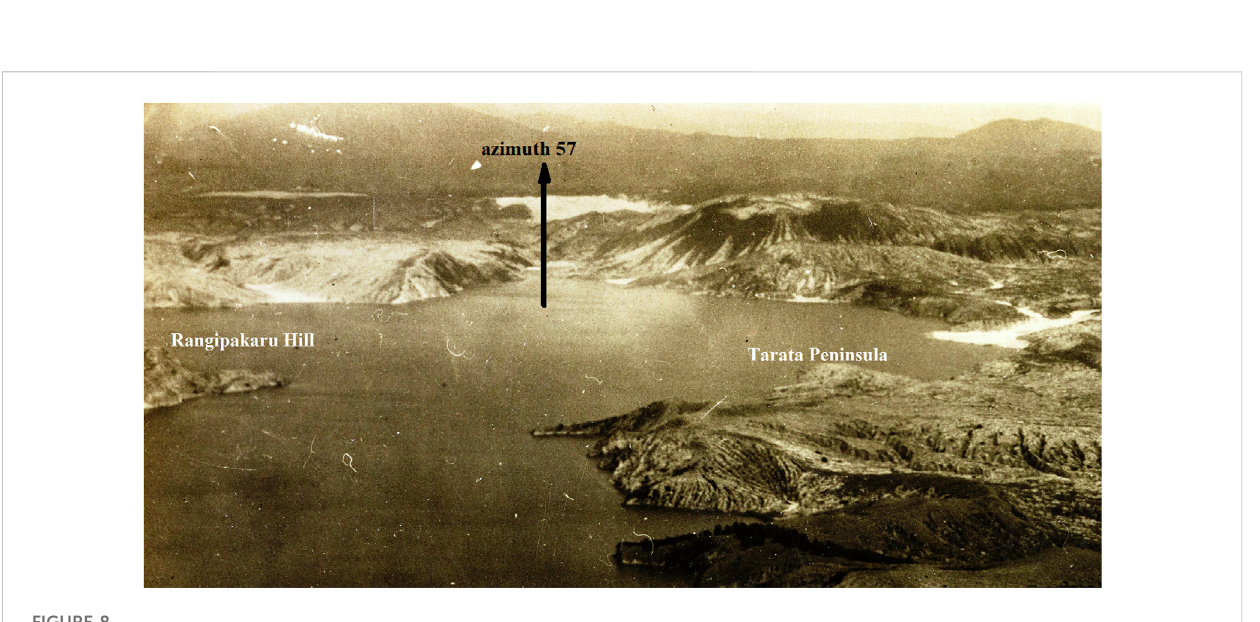
his 30 April map. The solfatara scale and steaming fog con fi rm that geothermal activity predated the 1886 Tarawera eruption. This assists the question puzzling Tontini in 2015: the absence of a well-de fi ned demagnetization anomaly at the Patiti hydrothermal system (Tontini et al., 2015). Hochstetter ’ s observation station on